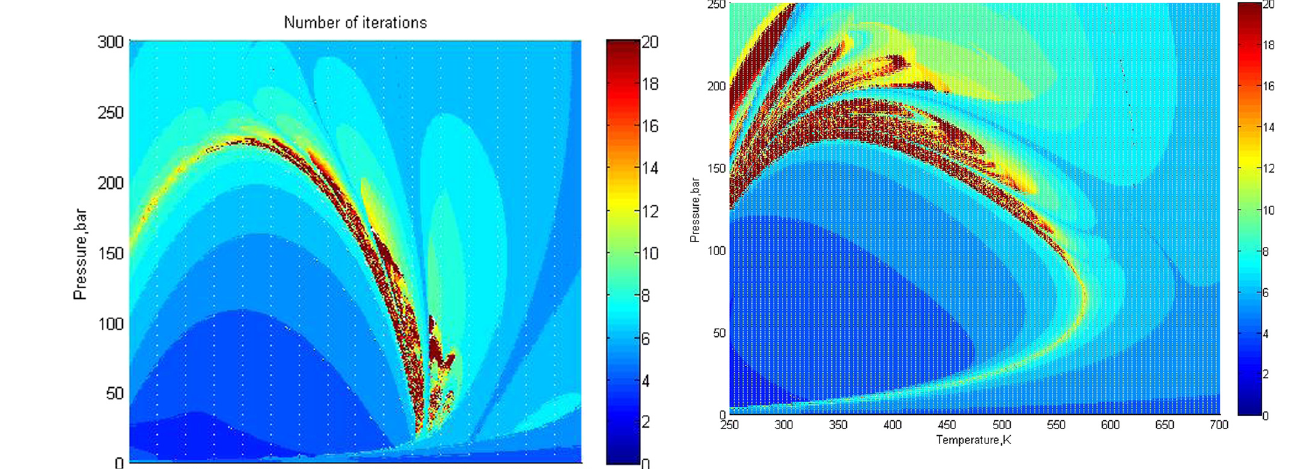
Figure 4: Number of iterations for the MY10 mixture, proposed method with type L